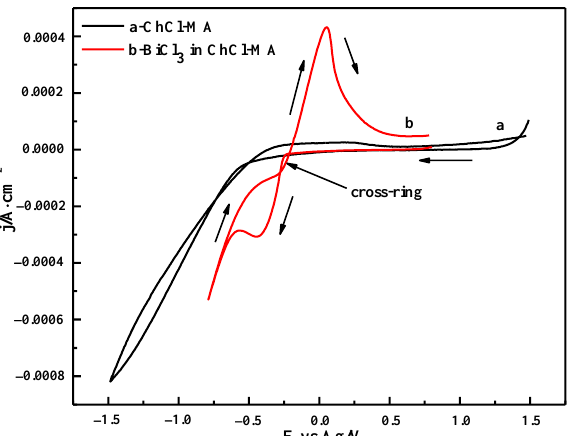
Figure 8. Cyclic voltammogram of the ChCl-MA blank system and ChCl-MA-BiCl 3 (T = 343 K, v = 20 mV · s − 1 , c(BiCl 3 ) = 0.10 M).